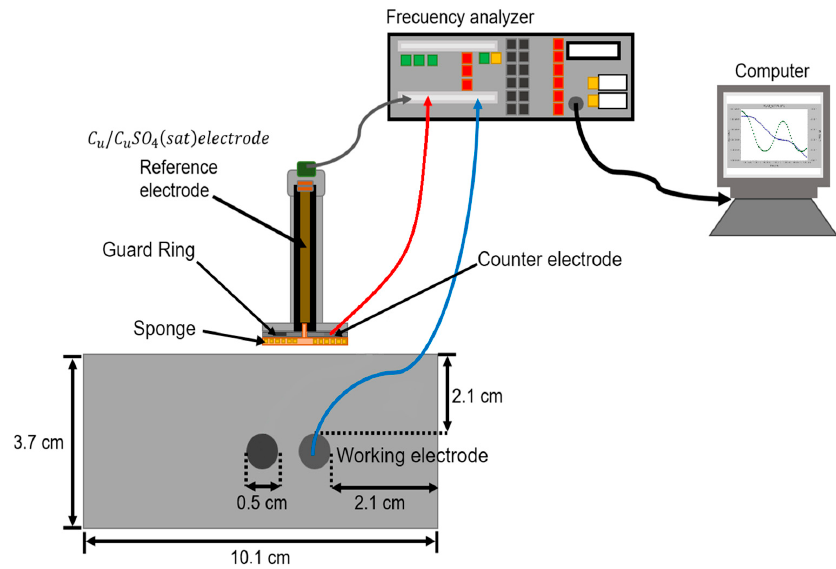
Figure 2. Experimental setup for the characterization of reinforced concrete samples.